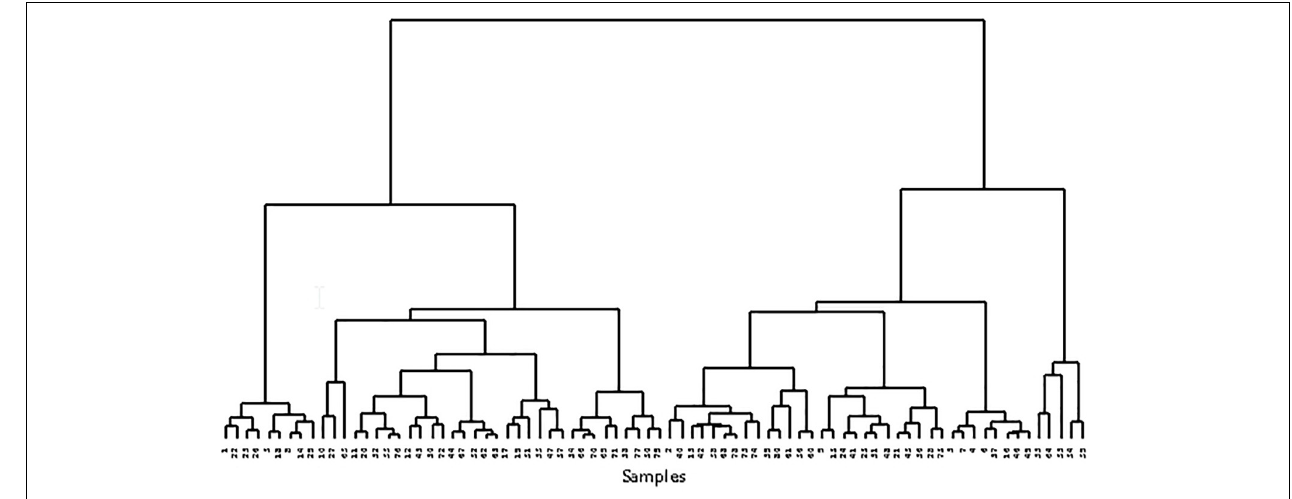
FIGURE 4 | Dendrogram of soil samples at the former painting production facility.